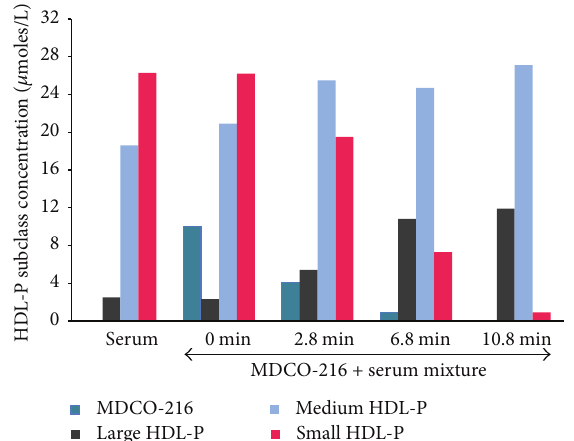
Figure 4: Changes in MDCO-216 and HDL subclass concen- trations brought about by incubation of MDCO-216 with serum at 47 ∘ C. HDL subclass concentrations ( 𝜇 mol/L) were derived by deconvolution analysis using a model that included MDCO-216. Only relative concentrations of MDCO-216 are given, with the starting concentration in the 0min digital mixture set arbitrarily to 10 𝜇 mol/L for graphical display